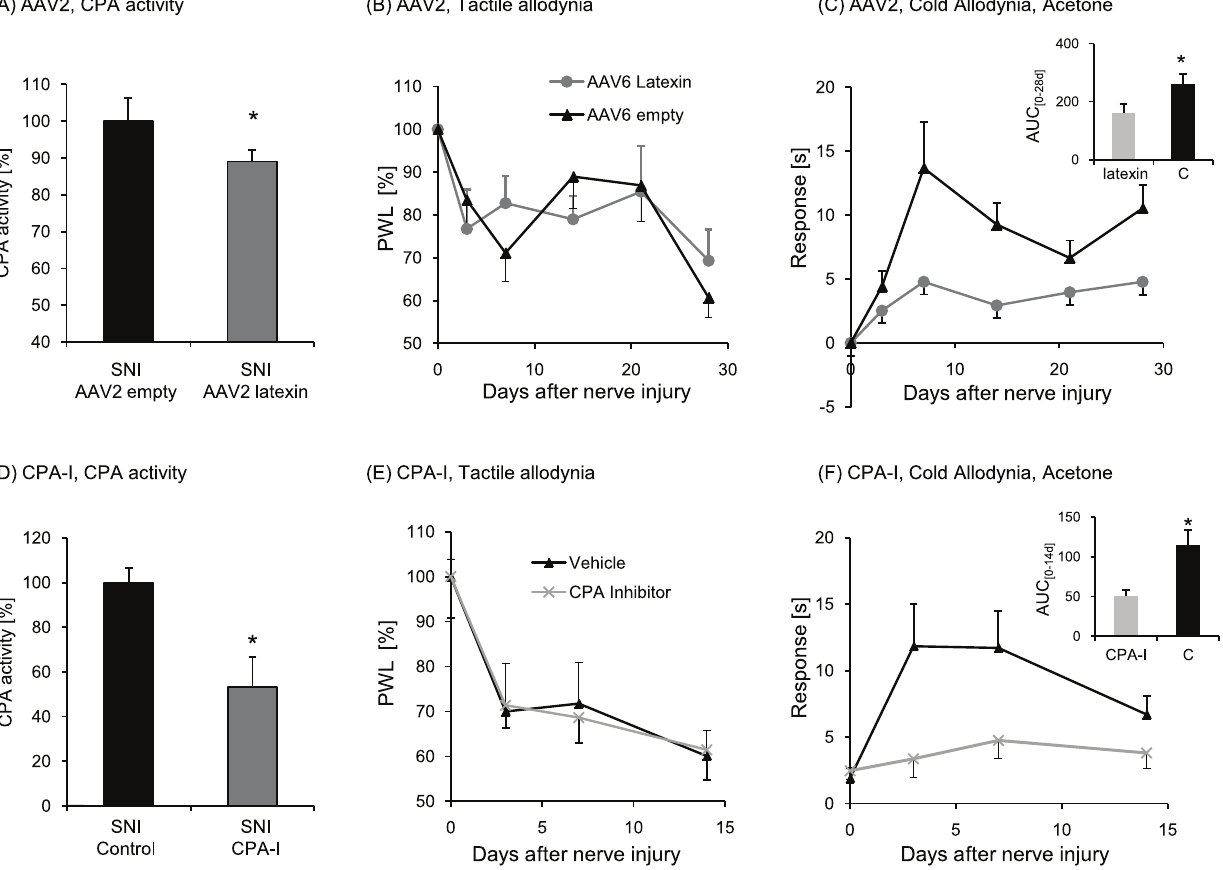
Figure 5. Nociceptive behavior after CPA-inhibition either by AAV-mediated latexin rescue or the CPA inhibitor D, L-benzylsuccinic acid. (A) CPA activity in the spinal cord of SNI treated mice injected either with adenoassociated virus backbone (empty AAV2) or AAV2-latexin. (n=5–6/group). CPA activity of controls is set at 100%. (B) Mechanical hyperalgesia assessed with a dynamic von Frey apparatus and (C) cold allodynia assessed in the acetone test in AAV2 treated mice. (n=13–14 animals in each group), m empty AAV2, spinal cord of SNI treated mice with or without oral administration of the CPA inhibitor racemate (CPA-I) D, L-benzylsuccinic acid. (n=5/group). Controls are set at 100%. (E) and (F) mechanical hyperalgesia and cold allodynia in control and D, L-benzylsuccinic acid treated mice, respectively. (n=6 animals in each group), m controls, X CPA-Inhibitor. Data are means 6 SEM, *P , 0.05.